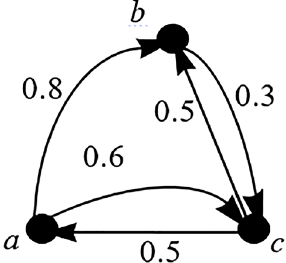
Figure 5. An FACS.